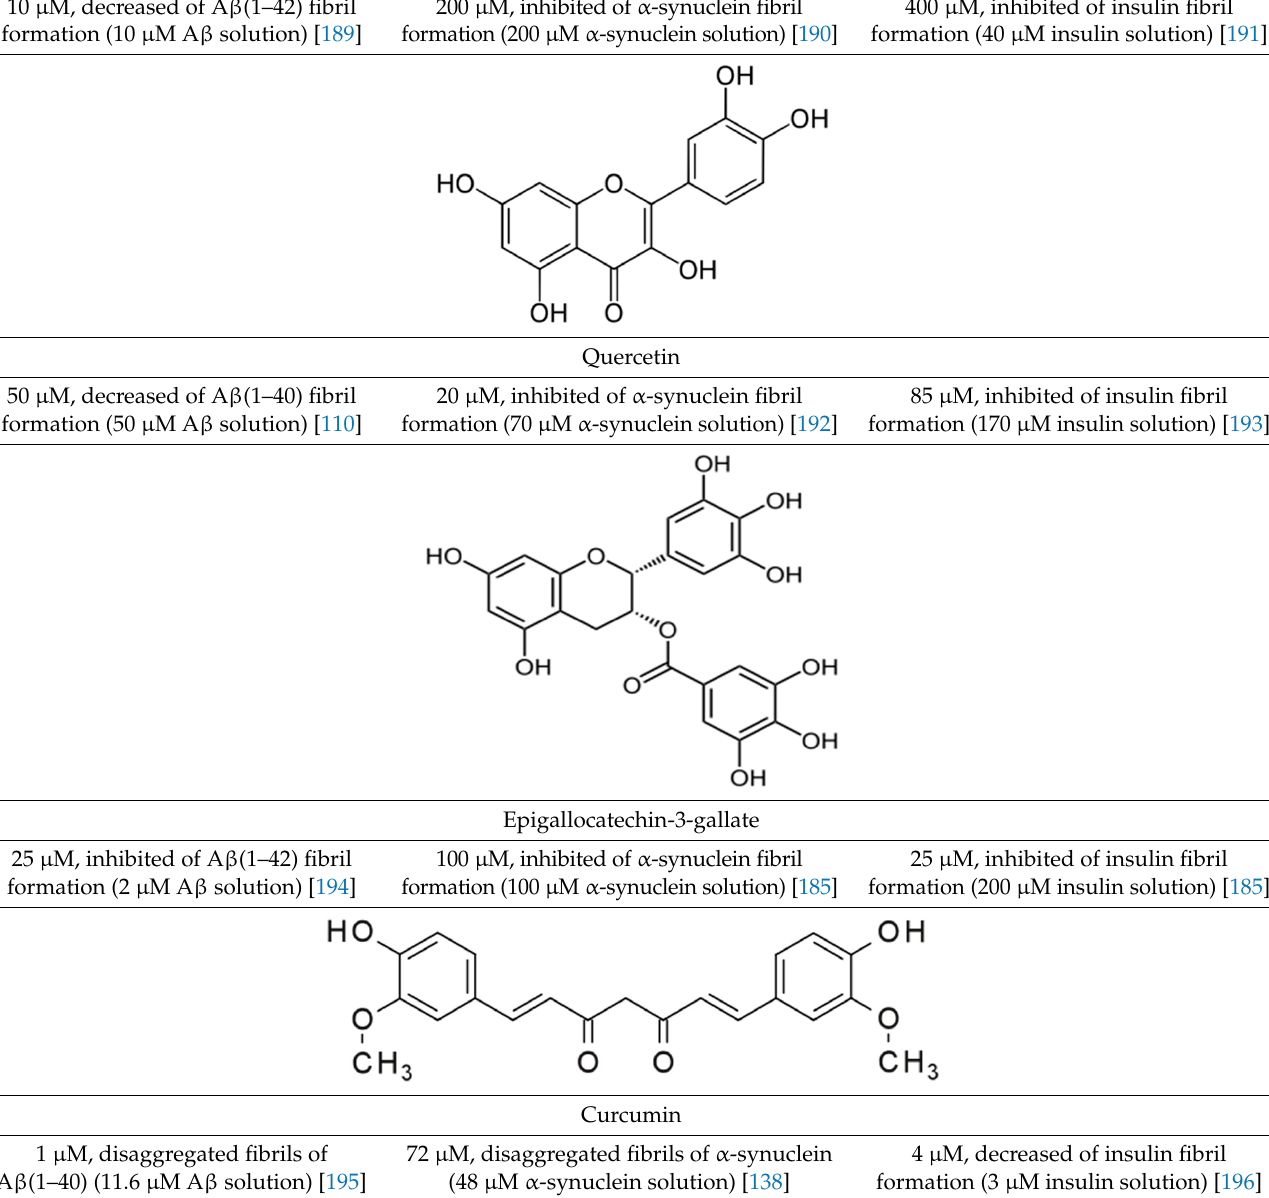
Table 1. Common inhibitors for A β , α -synuclein, and insulin. A